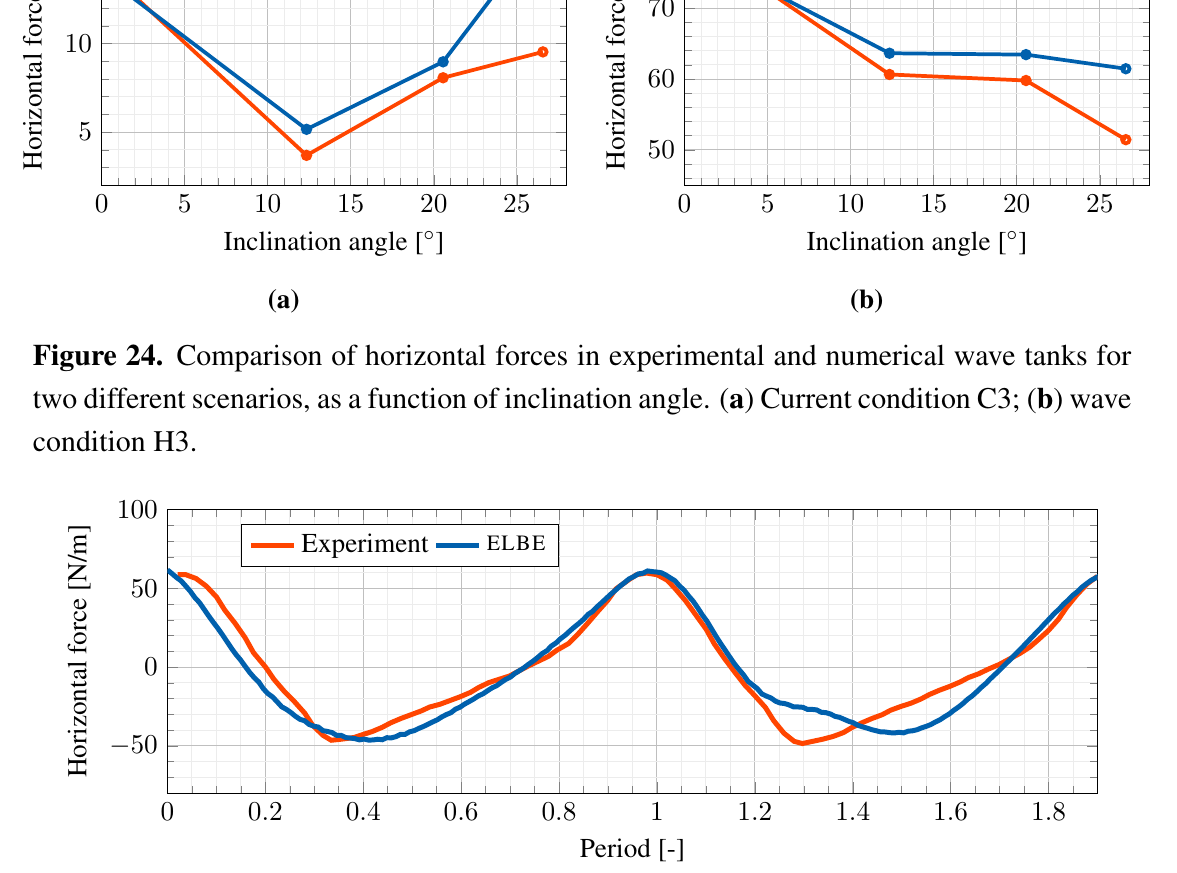
Figure 25. Comparison of transient experimental and numerical results for the horizontal hydrodynamic forces; two selected wave periods, Geometry